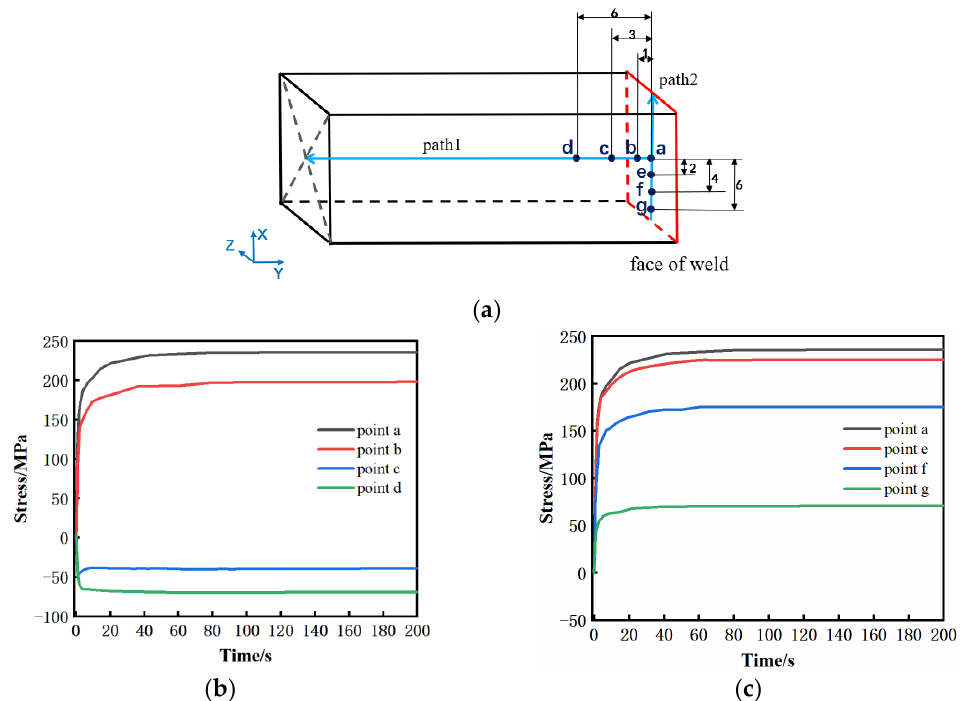
Figure 13. Stress time curve of key points in the lengthwise direction in the early cooling period (within 200 s); ( a ) points diagram; ( b ) key points in path 1; ( c ) key points in path 2.